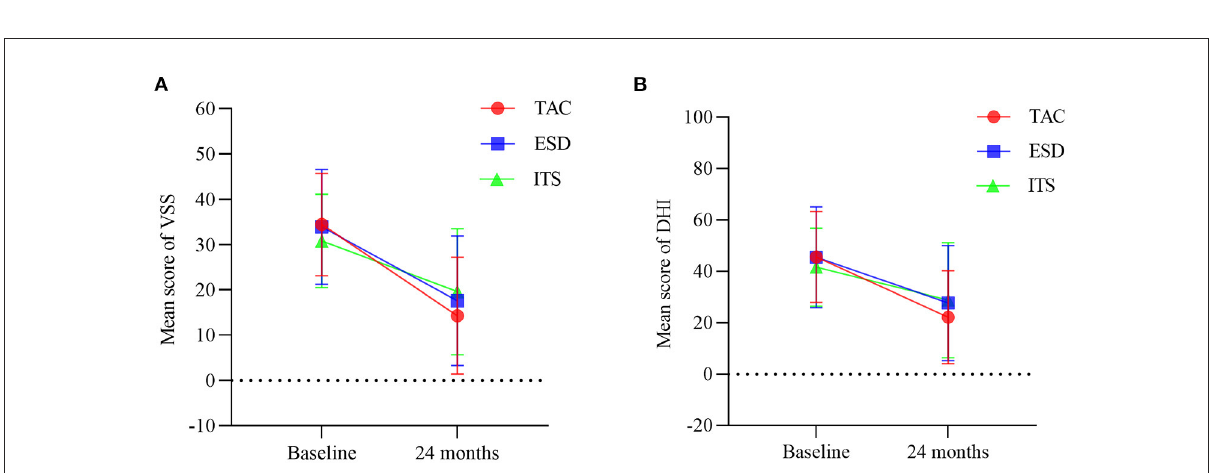
FIGURE3 Mean scores for (A) vertigo symptom scale and (B) dizziness handicap inventory at baseline and 24 months (bars are SDs). TAC, tympanic antrum catheterization; ESD, endolymphatic sac decompression; ITS, intratympanic steroid.